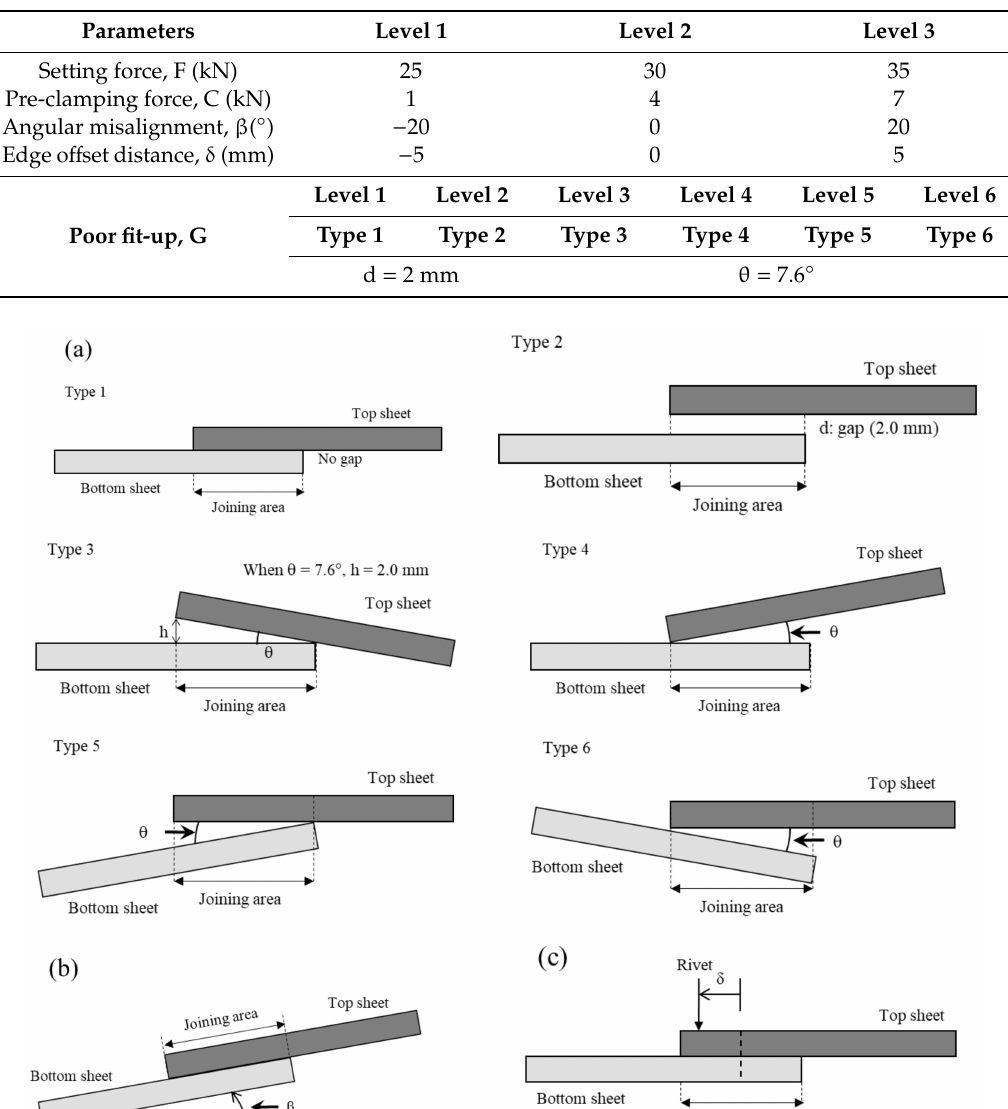
Figure 1. Dimensions of rivet and die. ( a ) Rivet; ( b ) die. Table 2. Joining parameters applied in this study.